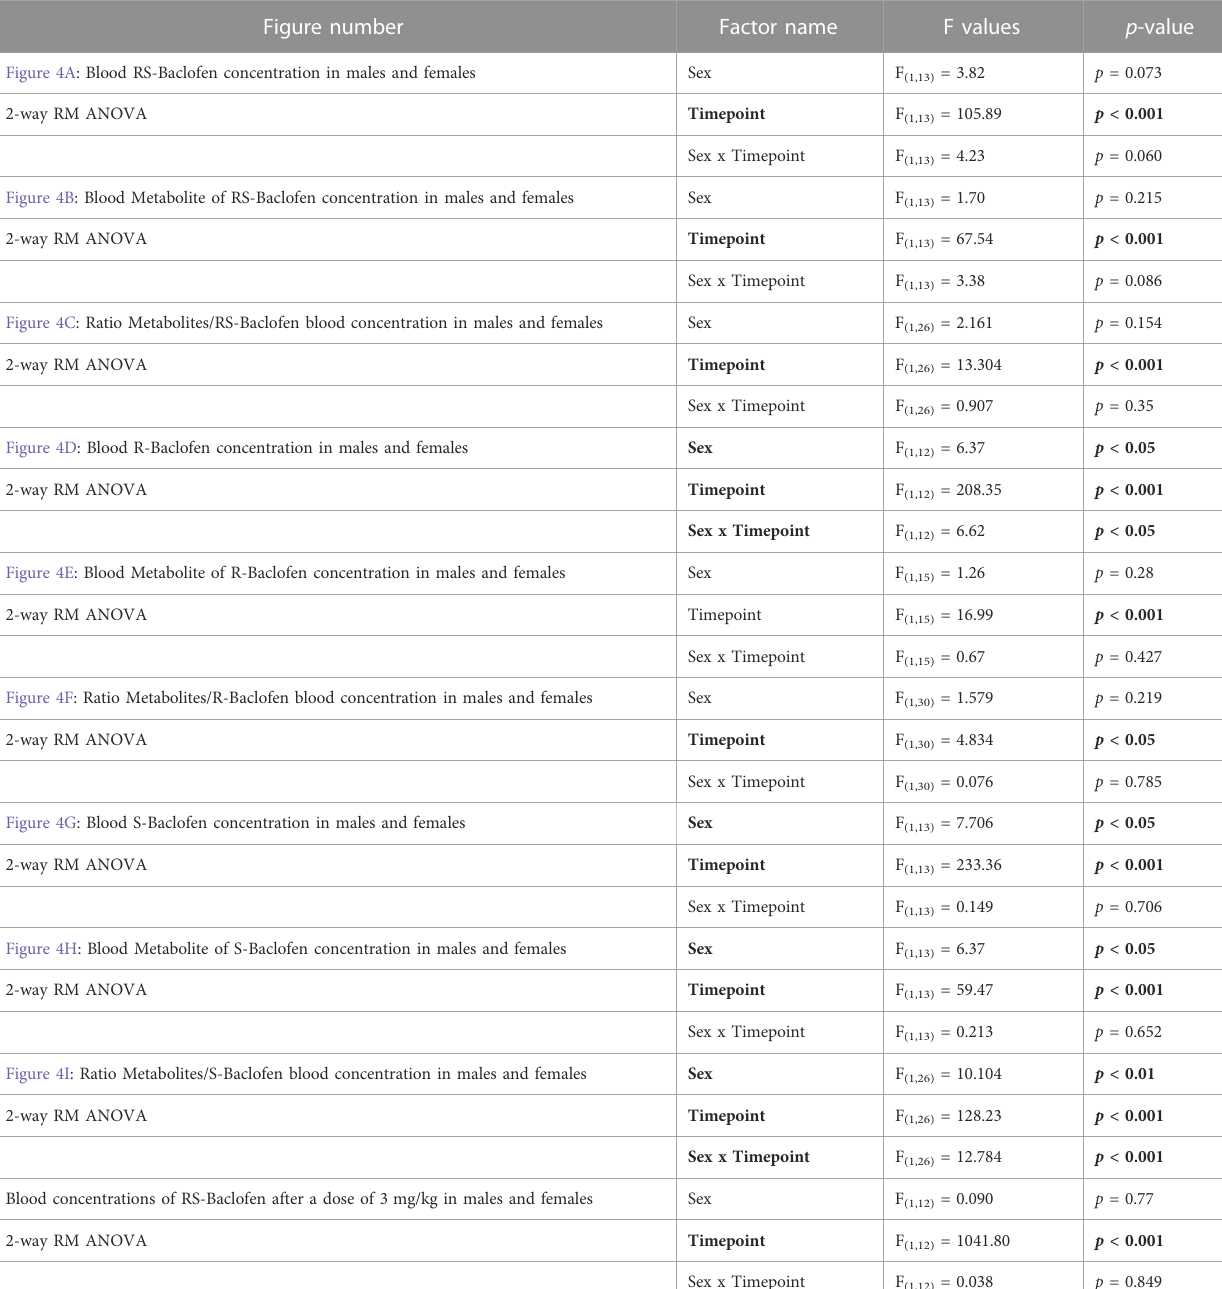
TABLE 1Statistical analysis of the blood concentration of the different baclofen enantiomers and their metabolites afteran i.p. injection of a dose of 1.5 mg/kg at 30and240 minpost-administration.Statisticalanalysisofthebloodconcentrationsofthedifferentformsofbaclofenandtheirmetabolites.Theenantiomersand the racemic form were i.p. injected at a dose of 1.5 mg/kg in males and females, then blood was collected 30 and 240 min after the injection. Samples were analyzed by HPLC. Bold characters indicate a signi fi cant main effect and/or an interaction following a 2-way RM ANOVA.